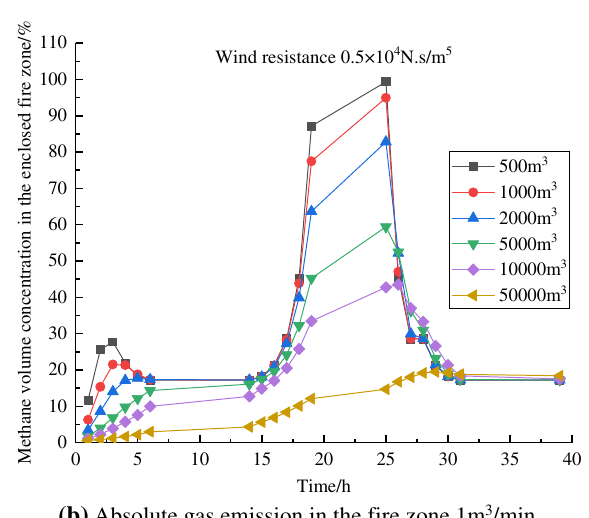
(a) Absolute gas emission in the fire zone 10m 3 /min